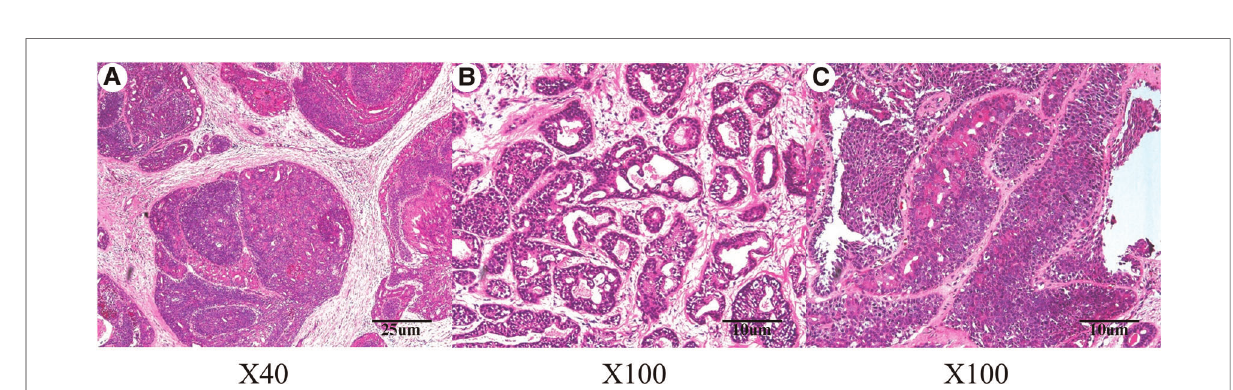
FIGURE 2 Hematoxylin – eosin staining indicated malignant adenomyoepithelioma of the breast lump. ( A ) Magni fi cation of the main body of the lump (original magni fi cation ×40); ( B ) magni fi cation of the main body of the lump (original magni fi cation ×100); ( C ) magni fi cation of the different areas of the lump body (original magni fi cation ×100).